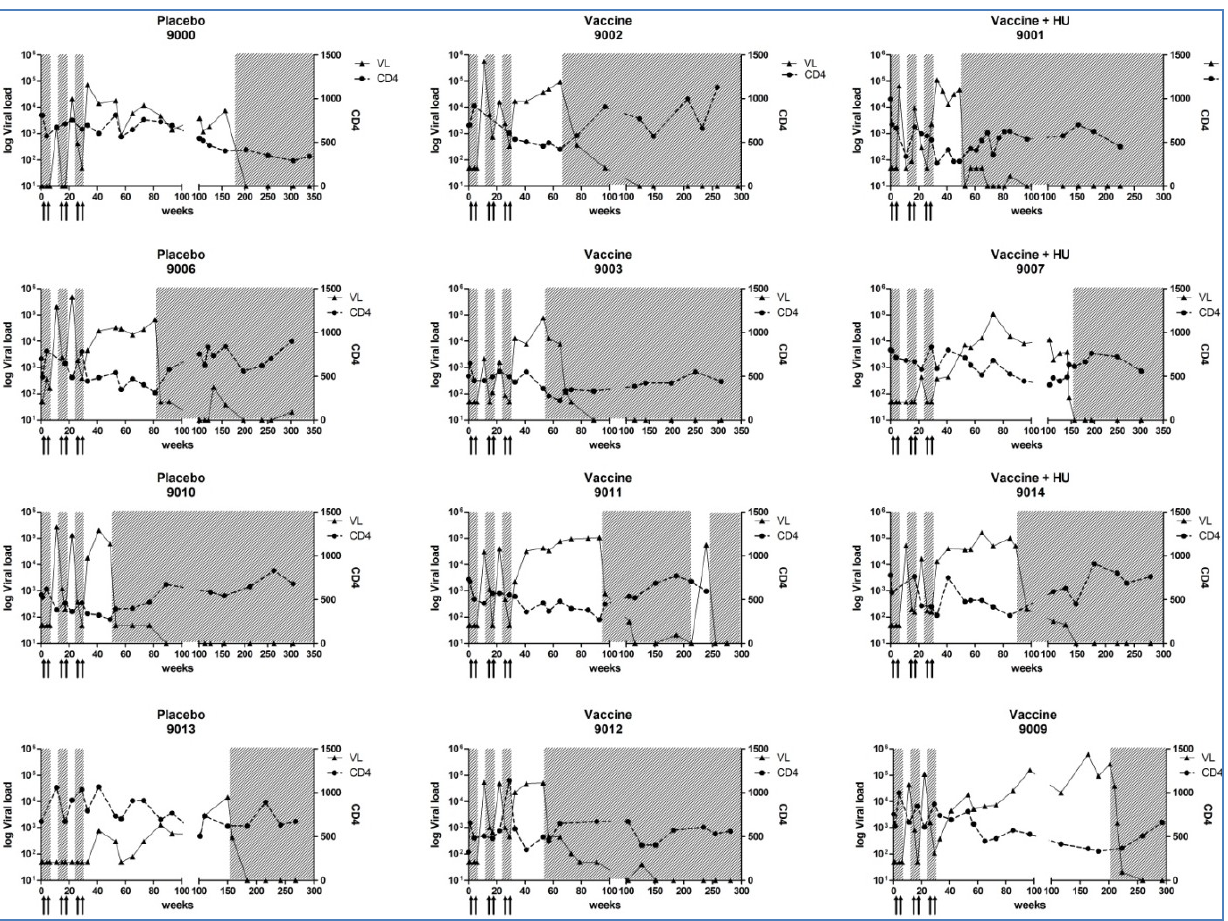
Figure A1. Schedule of 12 adult vaccinees. CD4+ T-cells (bullets) and HIV-1 viral load (triangles) during vaccination (arrows) and repeated structured therapy interruption (STI) (white fields). All patients finally resumed antiretroviral therapy (shaded